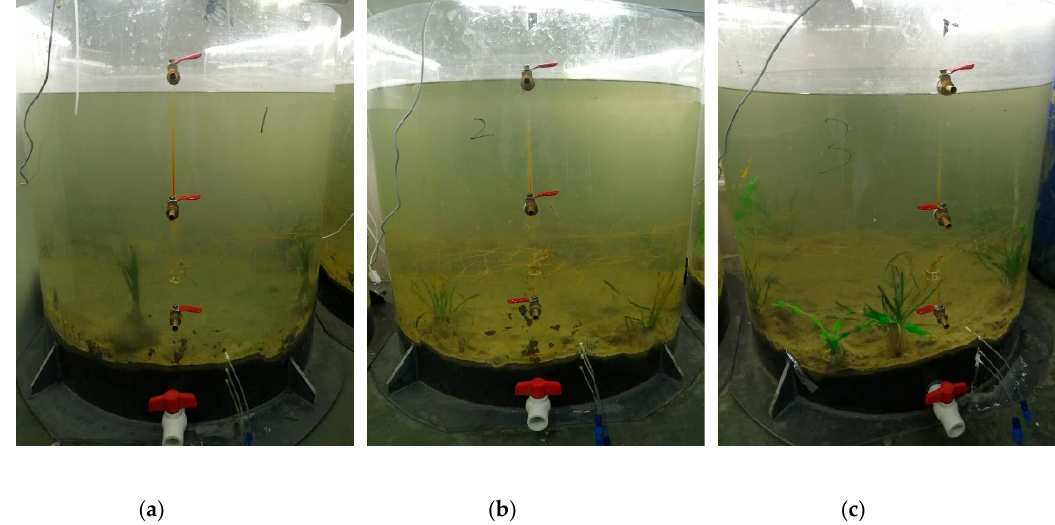
Figure 2. Experimental units for V. natans plants transplanted. Notes: ( a ) is mud-sinking method (MS); ( b ) is agar gel-sinking method (AS); ( c ) is agar gel-sinking with artificial aquatic mat method (ASA).